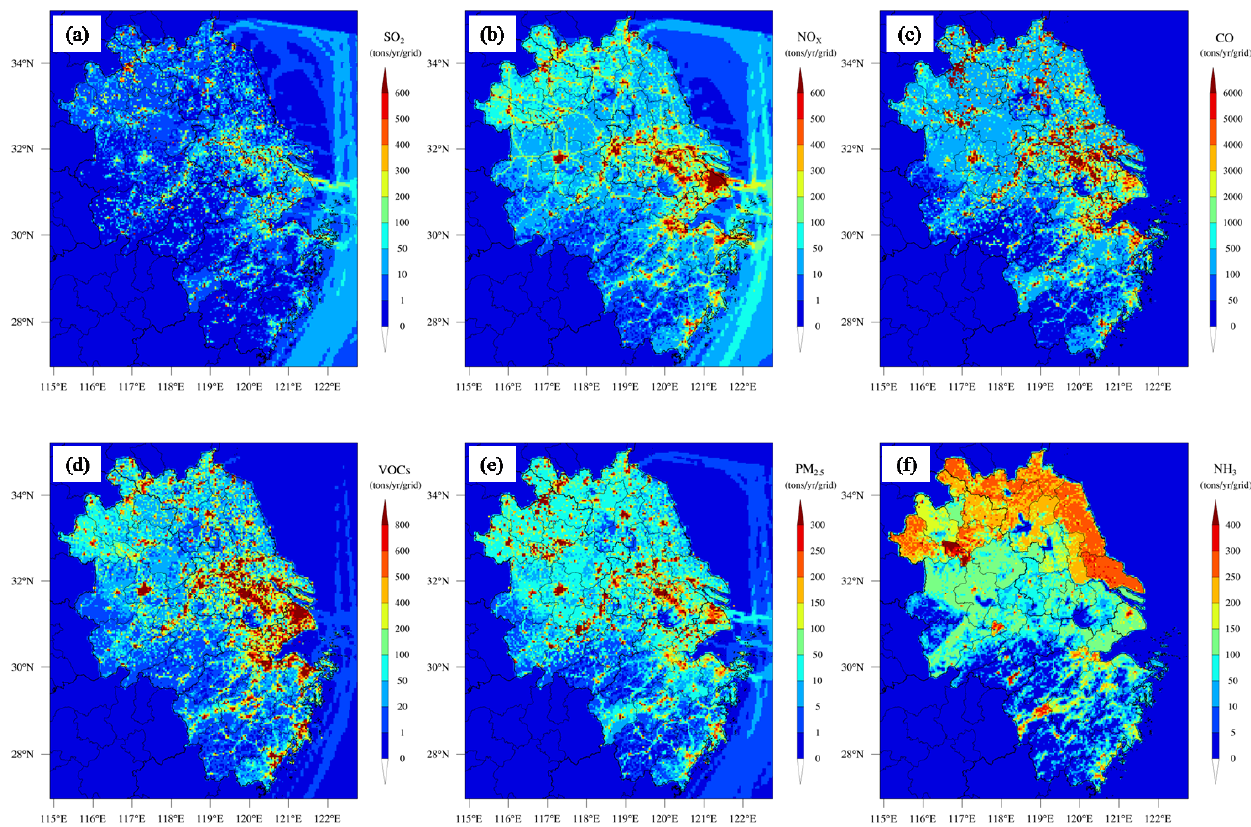
Figure 4. Spatial distribution of major air pollutant emissions in the YRD region: panels (a) – (f) represent SO 2 , NO x , CO, NMVOCs, PM 2 . 5 , and NH 3 ,